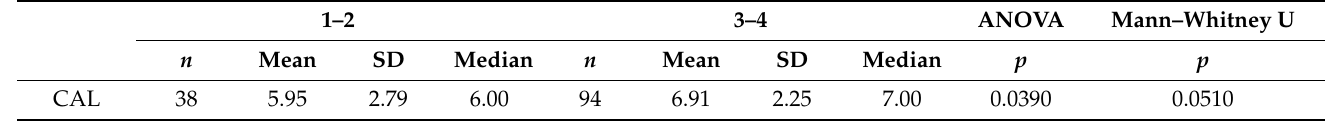
Table 10. The number of atherosclerotic altered arteries versus mean CAL at interproximal